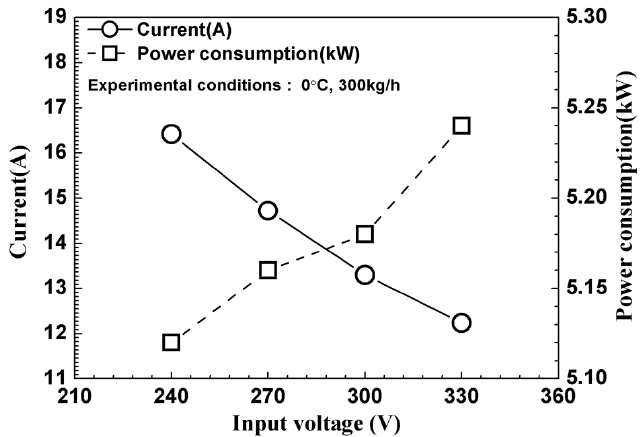
Figure 7. Variation of current and power consumption.